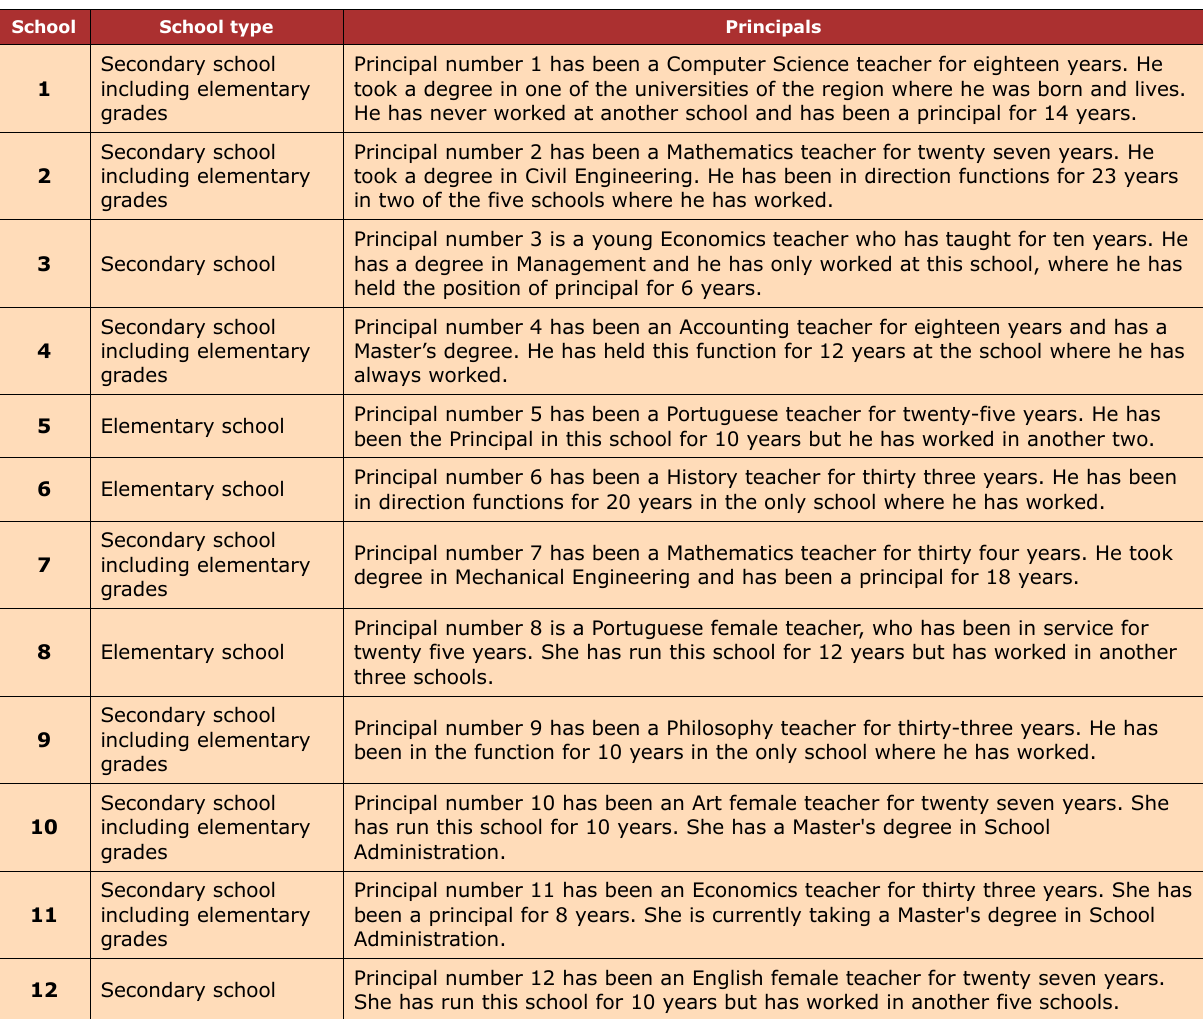
Table 1. Profile of respondents and respective types of